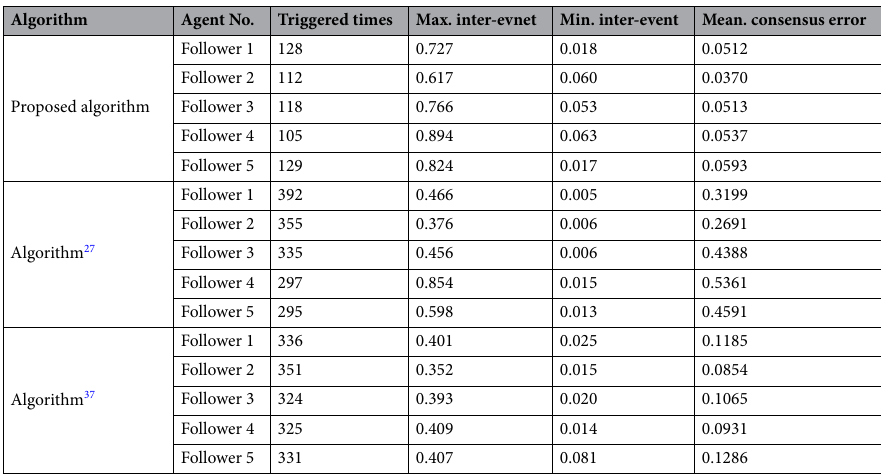
Table 1. Some statistics of the multiagent system in the simulation, total sampling times are 30001 (Max. inter-evnet, Min. inter-event and Mean. consensus error represents the maximum inter-evnet time (s), the minimum inter-evnet time (s) and the average consensus error (m) in the simulation, respectively).